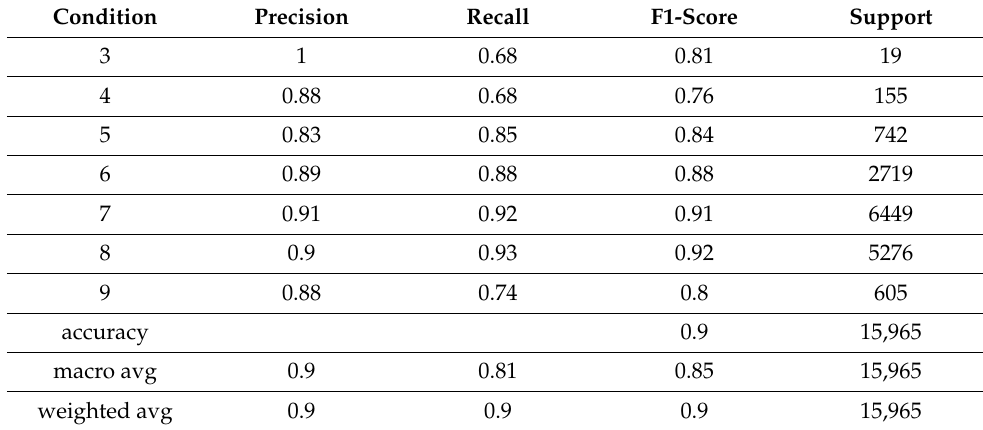
Table 7. Test accuracy of the superstructure model.